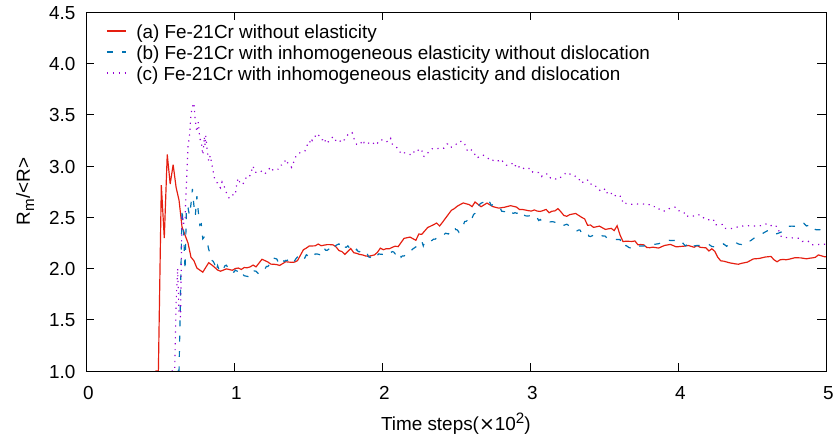
Figure 5. R m /< R > with respect to time for the cases of (a) without elasticity, (b) with inhomogeneous elasticity without dislocation, and (c) with inhomogeneous elasticity and dislocation, where R m is the maximum radius of the α (cid:48) precipitate and < R > is the average radius of it. We performed four different sets of simulations to evaluate R m and < R > for enhanced statistical rigor of the analysis. The system size was 256 × 256 µ m 2 . The composition of the system is Fe-21Cr.